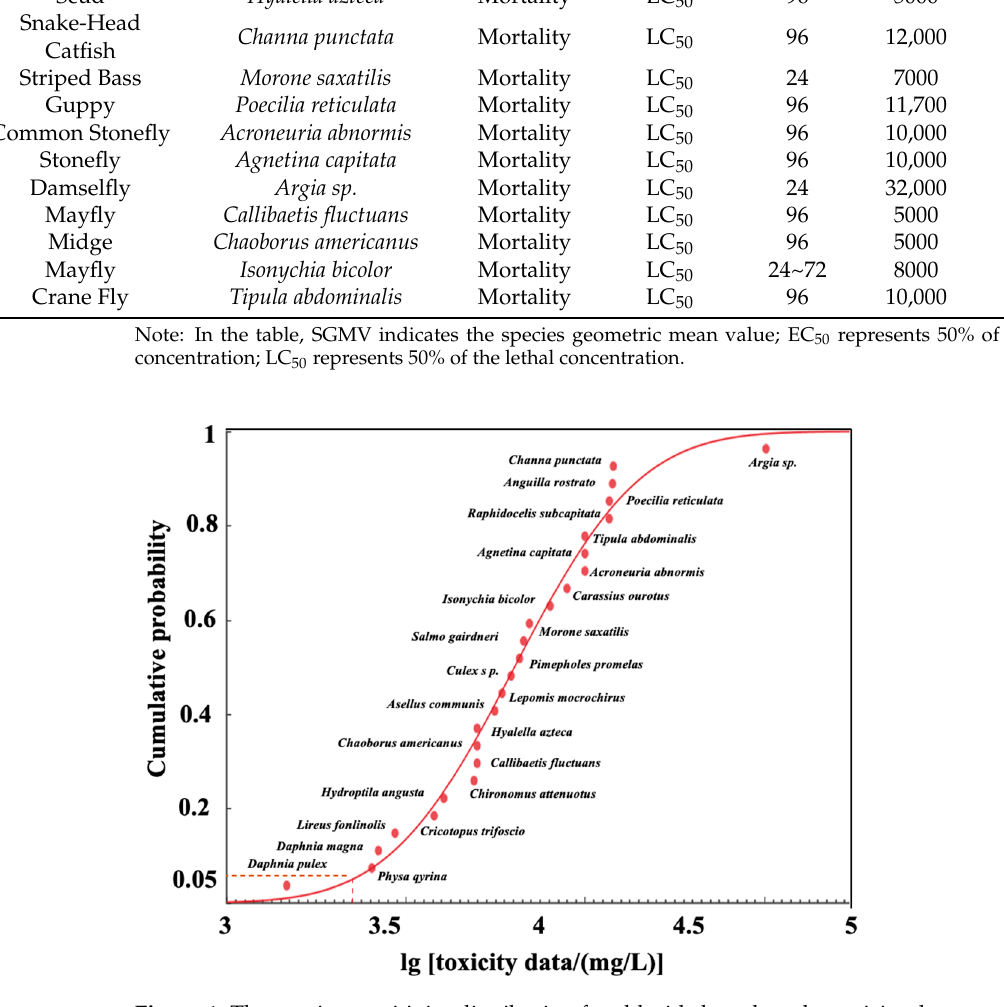
Figure 1. The species sensitivity distribution for chloride based on the toxicity data.